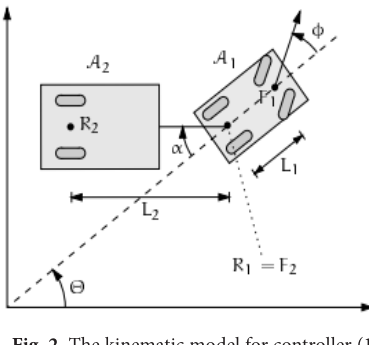
Fig. 2. The kinematic model for controller (1) Where α is the folding angle with which the motion occurs along the circle of r radius. On the phase trajectory (“basic”), the radius r0 is defined for the selected angle α. Then the required radius is determined by the formula r=((x1–x0) 2 + +(y1–y0) 2 )/(2*(y1–y0)) and, therefore, the required value of the folding angle is calculated: α=α0/(r/r0). Note that for the given controller, rectilinear motion is achieved when α–>0, since due to this approach computational features the zero value is not allowed.